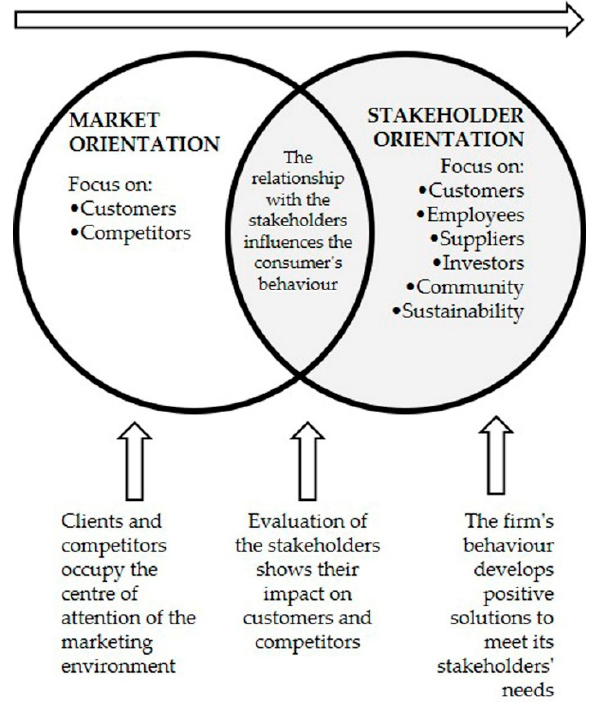
Figure 1. Transition from market orientation to stakeholder orientation. Source: Ferrell et al. (2010).